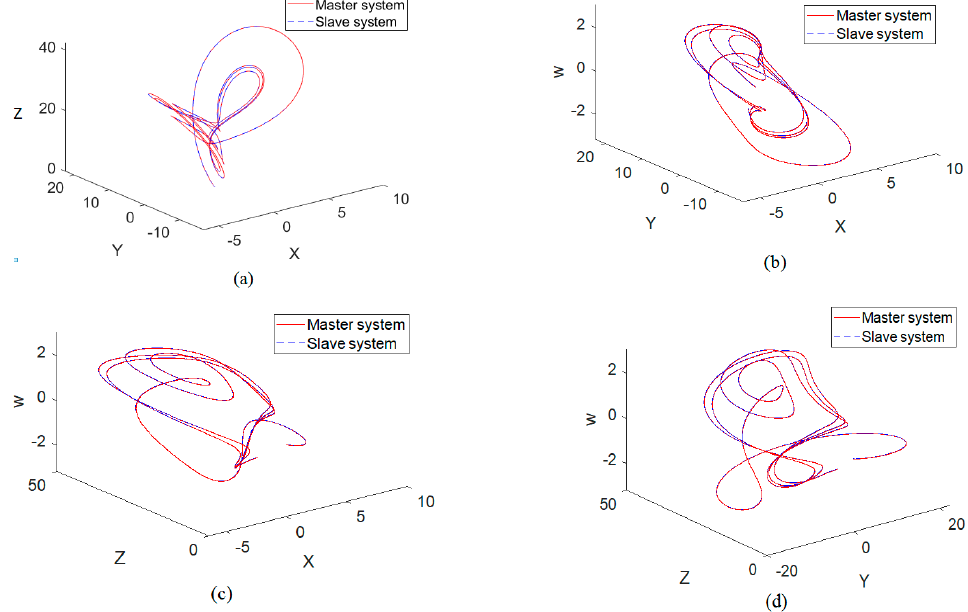
Figure 7. Synchronization of 4D Lorenz–Stenflo chaotic system using the SRIT2PC for Case 1: ( a ) x–y–z space, ( b ) x–y–w space, ( c ) x–z–w space, and ( d ) y–z–w